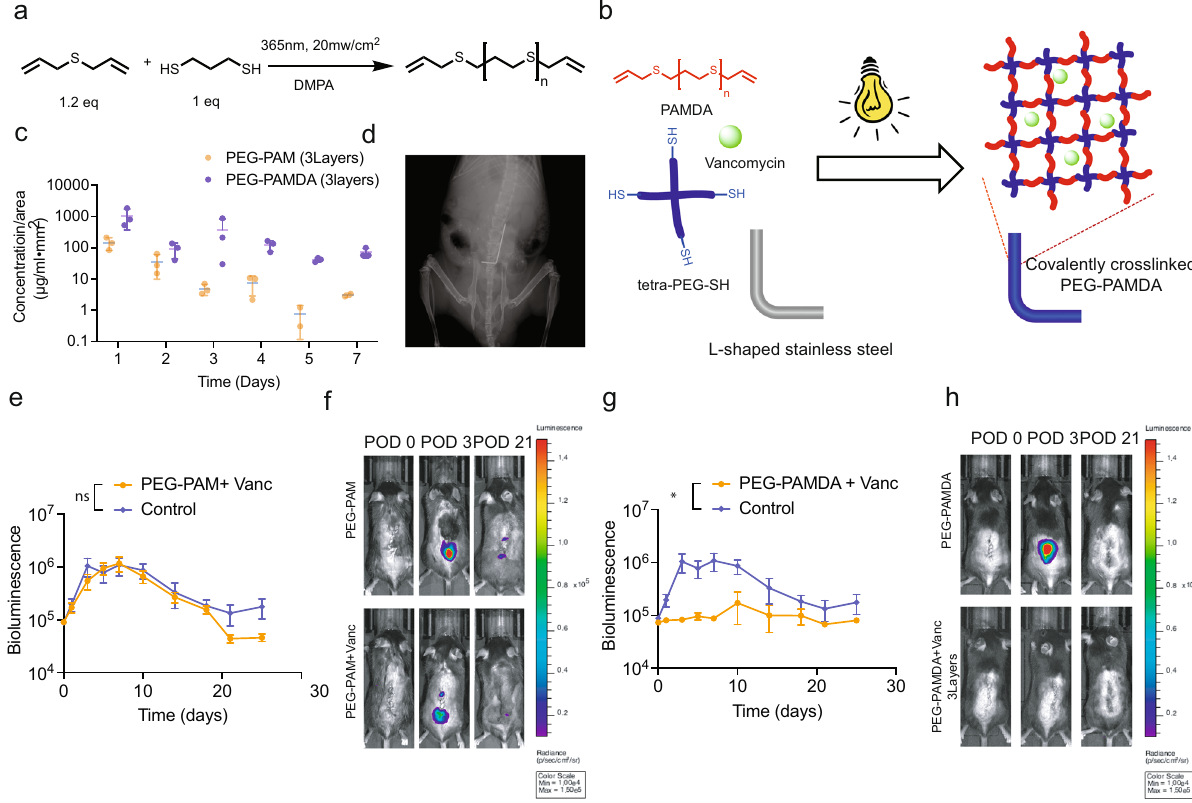
Fig. 7 In vivo evaluation of PEG-PAMDA coatings on spine surgery model with vancomycin. a Synthetic scheme for PAMDA synthesis. b Chemical crosslinking mechanism of tetra-PEG-SH and PAMDA. c In vitro release of vancomycin from PEG-PAM single layer coating and 3 PEG-PAMDA layers coating. d Representative X-ray image of spine surgery model ( e ) Postoperative in vivo S. aureus bioluminescence signals (mean maximum fl ux [photons/ sec/cm2/sr] (logarithmic scale) of single-layer PEG-PAM only and PEG-PAM with vancomycin on stainless spine implant. ( n = 3 for PEG-PAM group, n = 3 for PEG-PAM + Vanc group). f Representative in vivo S. aureus bioluminescence on a color scale overlaid on grayscale images of PEG-PAM with vancomycin and PEG-PAM only groups of POD 0, 3, and 21. g Postoperative in vivo S. aureus bioluminescence signals (mean maximum fl ux [photons/sec/ cm2/sr] (logarithmic scale)) of 3 layers PEG-PAMDA only and 3 layers PEG-PAMDA with vancomycin on stainless spine implant ( n = 6 for 3 layers PEG- PAMDA group, n = 6 for 3 layers PEG-PAMDA + Vanc group). h Representative in vivo S. aureus bioluminescence on a color scale overlaid on grayscale images of 3 layers PEG-PAMDA with vancomycin and 3 layers PEG-PAMDA only groups of POD 0, 3, and 21. Statistics in ( c , e , g ) are a two-way-repeated measure-ANOVA with multiple comparisons post-test. The signi fi cance between treatment groups was not signi fi cant for ( c ) and ( e ) and * p = 0.0116 for ( g ) Data is plotted showing the Standard Error of the Mean for time longitudinal